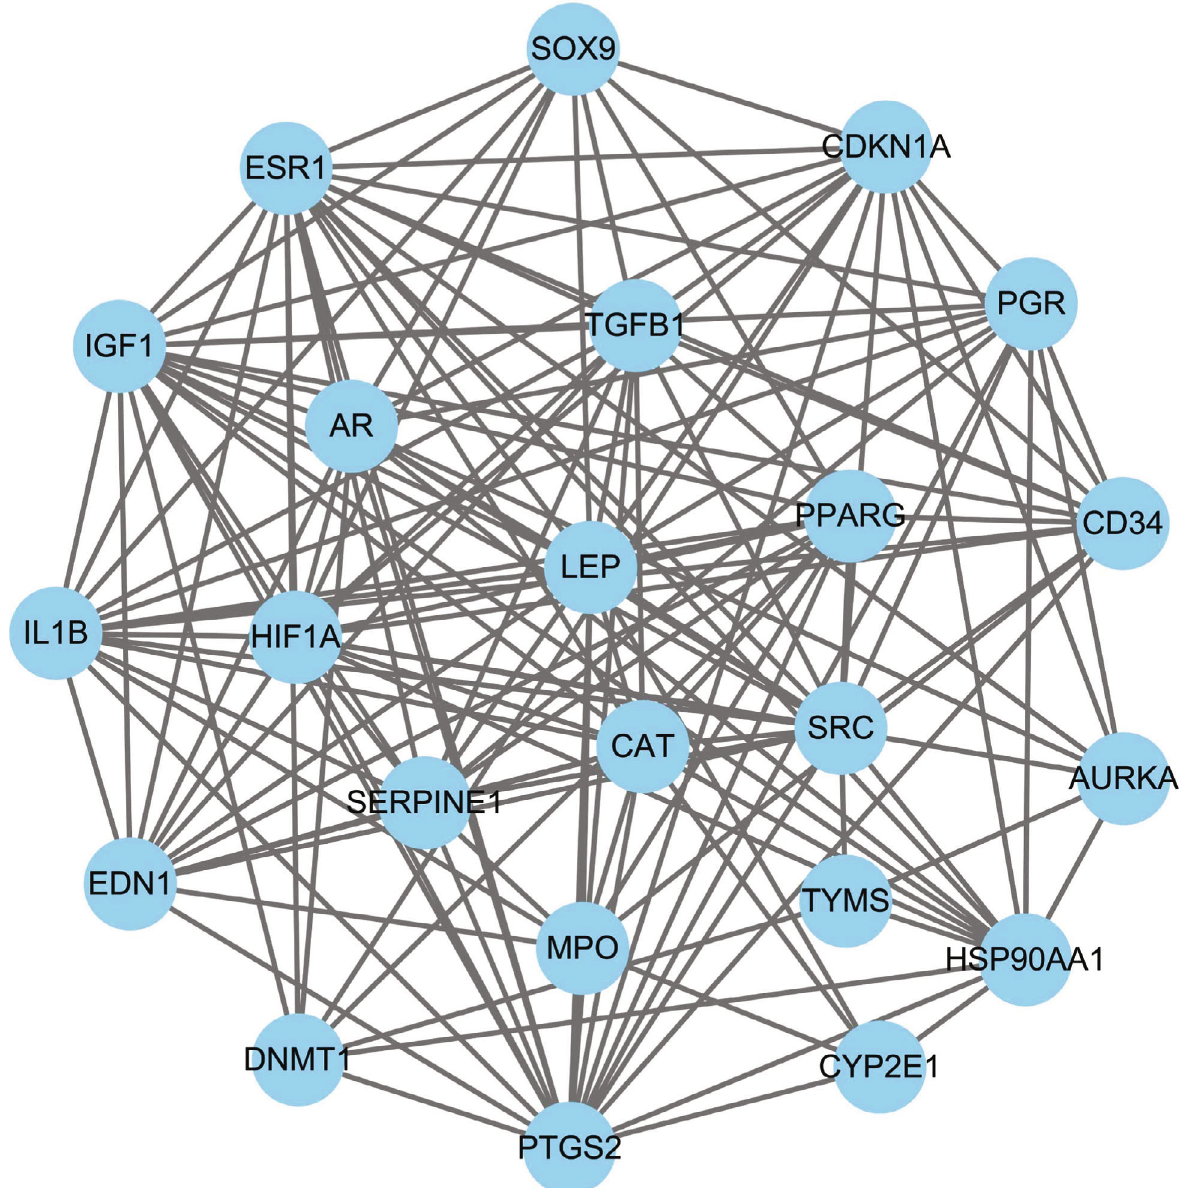
Figure 5: PPI interaction network of key target proteins of the